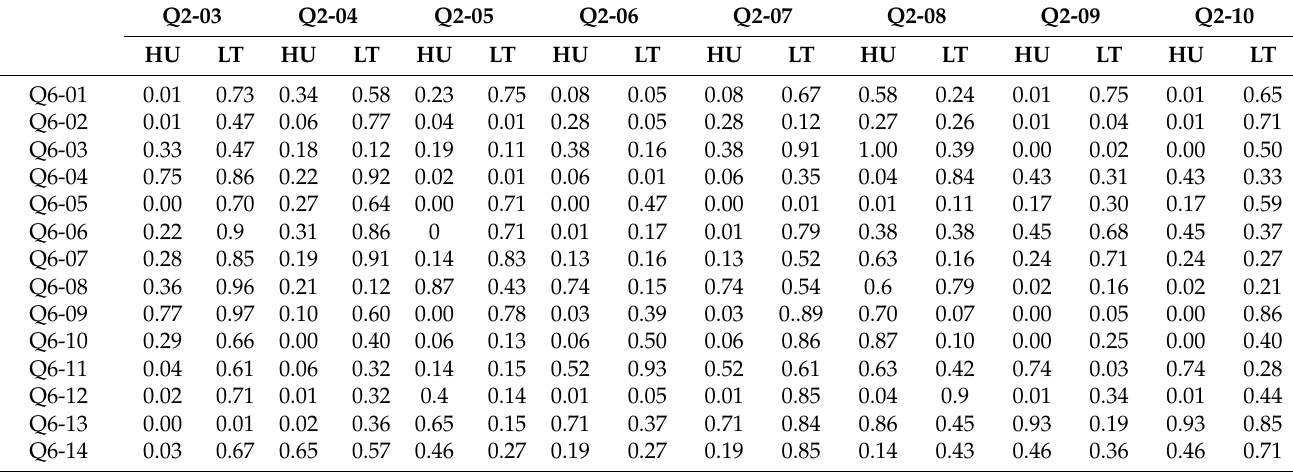
Table 3. p -values obtained by